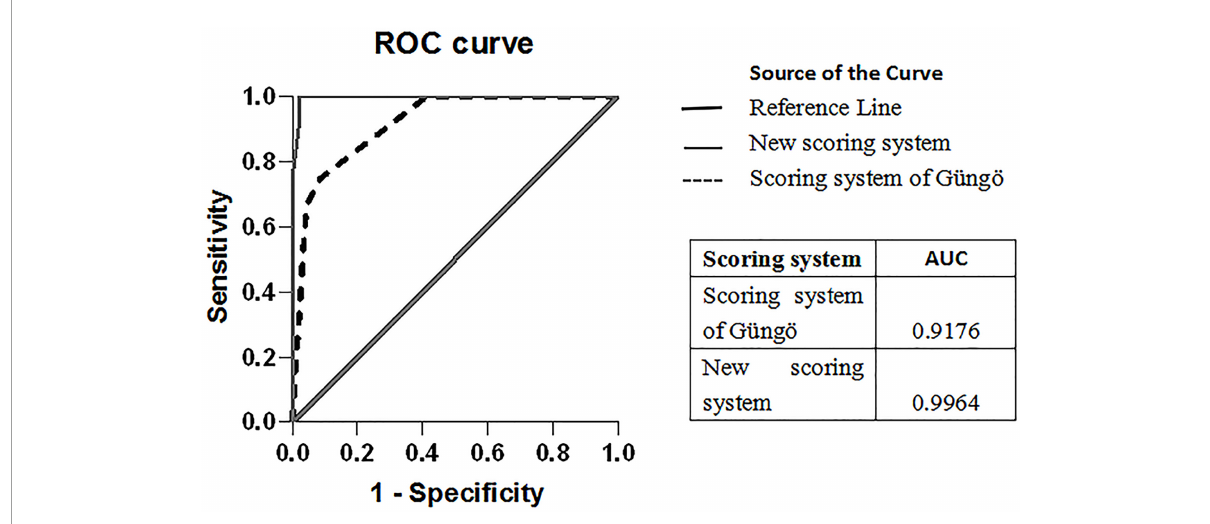
FIGURE2 ROC curves of the scoring system of Güngö et al. and our scoring system for ALF-WD. The comparison of the area under ROC for the scoring system is depicted in the box above.